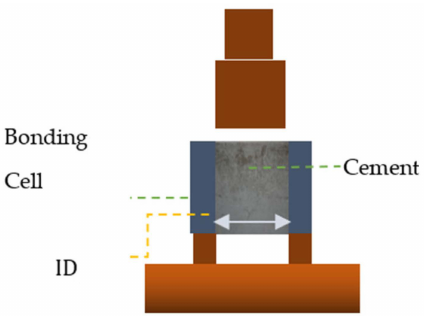
Figure 2. Interfacial Shear Bonding Strength test cells used in the current